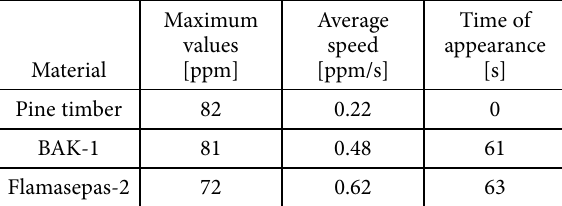
Table 7. The maximum values and average speed of growth in temperature during the first stage of combustion Maximum values Average speed Material [deg C] [deg C/s] Pine timber 58.8 0.39 BAK-1 55.0 0.37 Flamasepas-2 54.9 0.37 Table 8. The maximum values and average speed of growth in CO concentration during the first stage of combustion and time for the first appearance of carbon monoxide Maximum Average Time of values speed appearance Material [ppm] [ppm/s] [s] Pine timber 82 0.22 0 BAK-1 81 0.48 61 Flamasepas-2 72 0.62